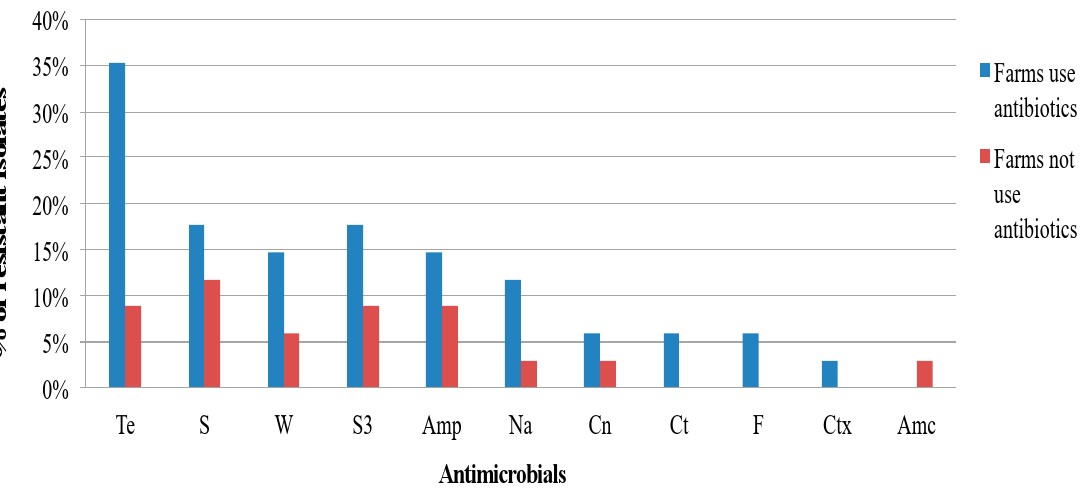
Figure 3. Frequency of resistance of Salmonella isolates from village chickens of the South-central Peninsular Malaysia according to the chicken production systems (Te, Tetracycline; S, Streptomycin; W, Trimethoprim; S3, Sulfonamides; Amp, Ampicillin; Na, Nalidixic acid; Cn, Gentamicin; Ct, Chloramphenicol; F, Nitrofurantoin; Ctx, Cefotaxime; Amc, Amoxicillin-clavulanate). Table 3. Distribution of multidrug resistant (MDR) Salmonella isolates recovered from native chickens of the South-central Peninsular Malaysia. Sources